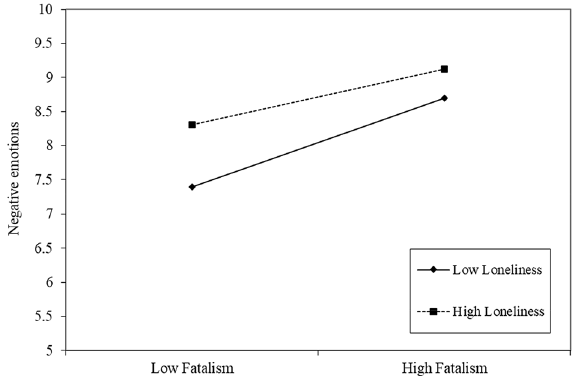
Figure 2. Moderation graph of the moderation for the buffer effect of experienced loneliness in the relationship between fatalism and negative emotions.